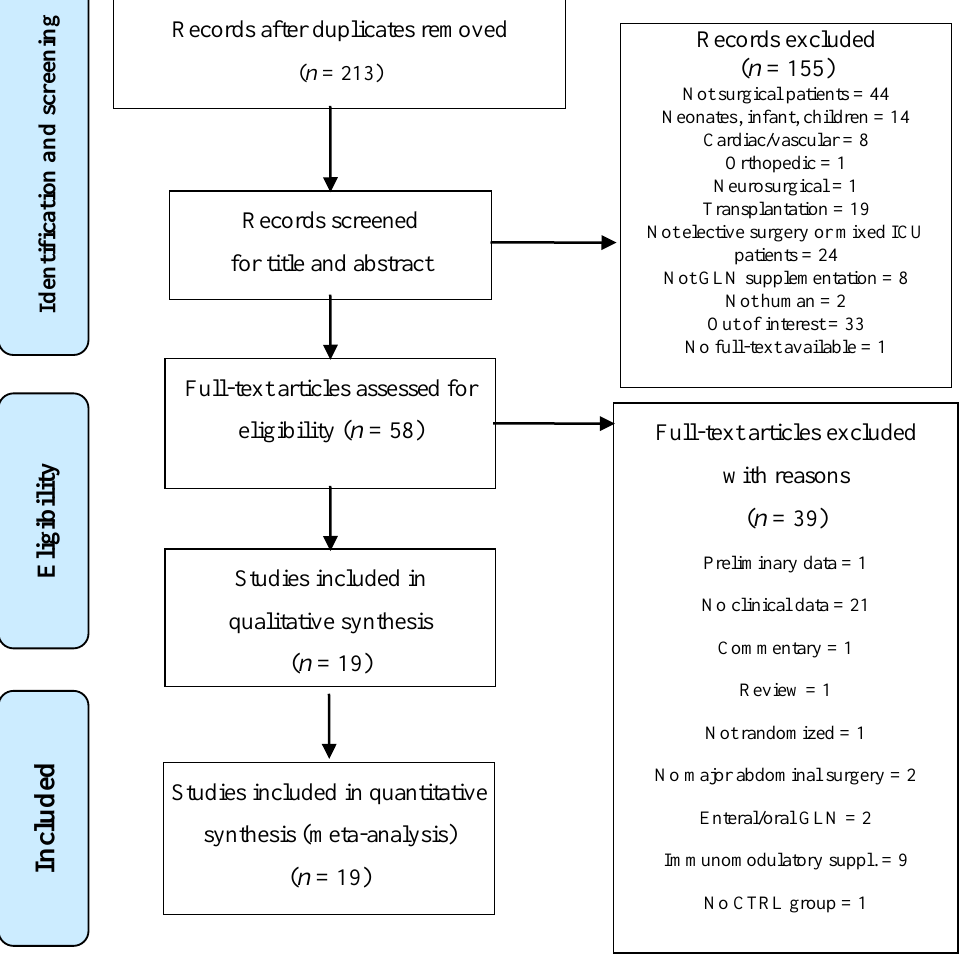
Figure 1. Flowchart of the literature search according the PRISMA